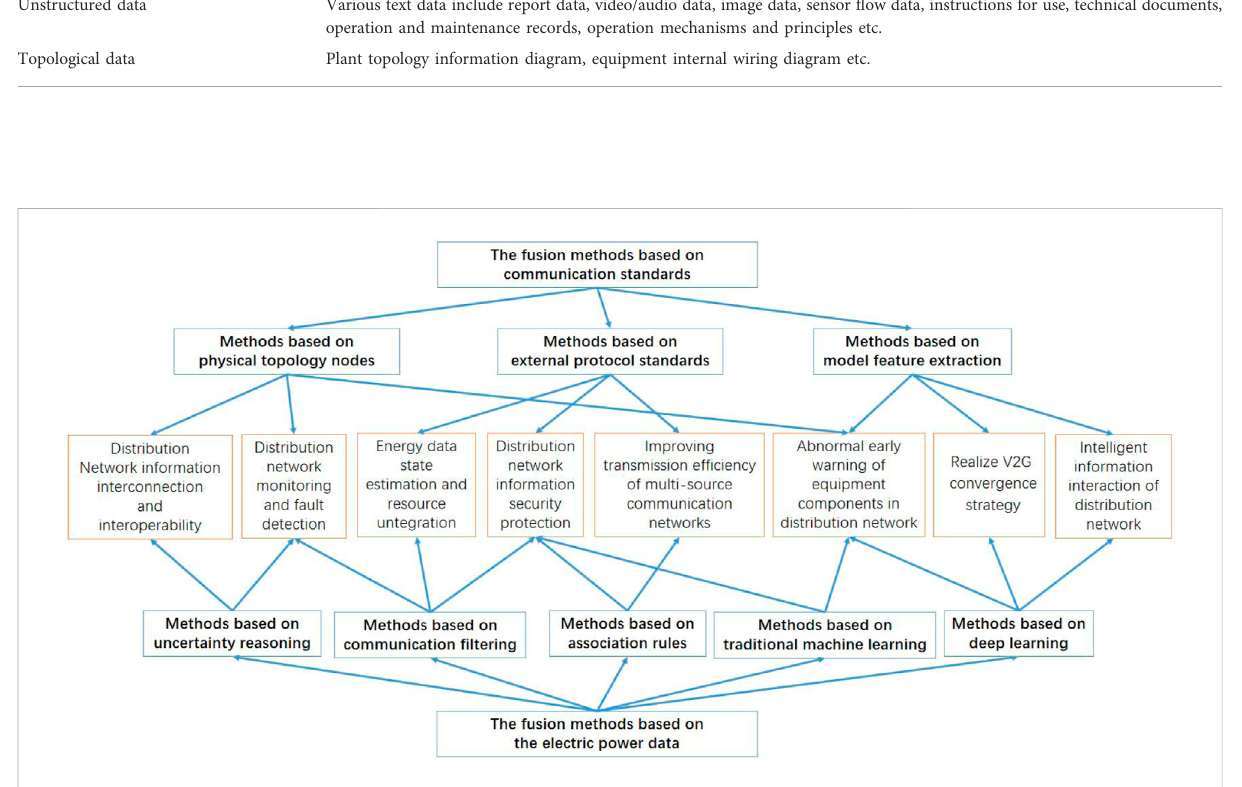
FIGURE 2 The classi fi cation of the fusion method for multi-source electric power